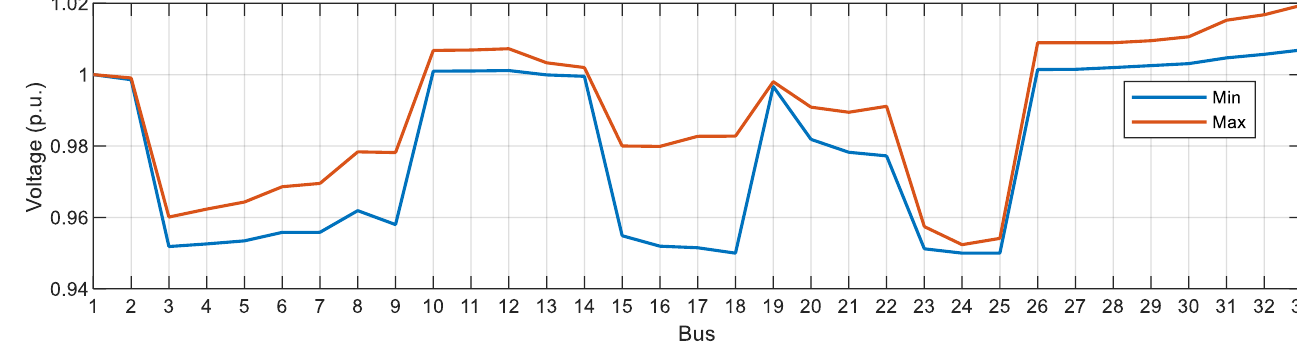
Figure 16. Minimum and maximum bus voltages in Scheme II.